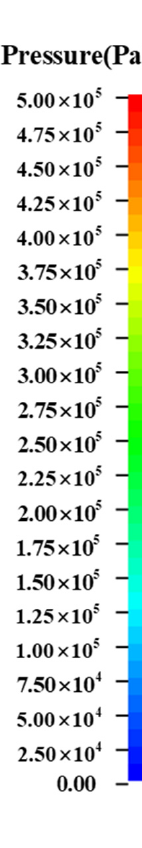
Figure 19. Shock wave propagation. ( a ) 0.09 ms; ( b ) 0.13 ms; ( c ) 0.20 ms.